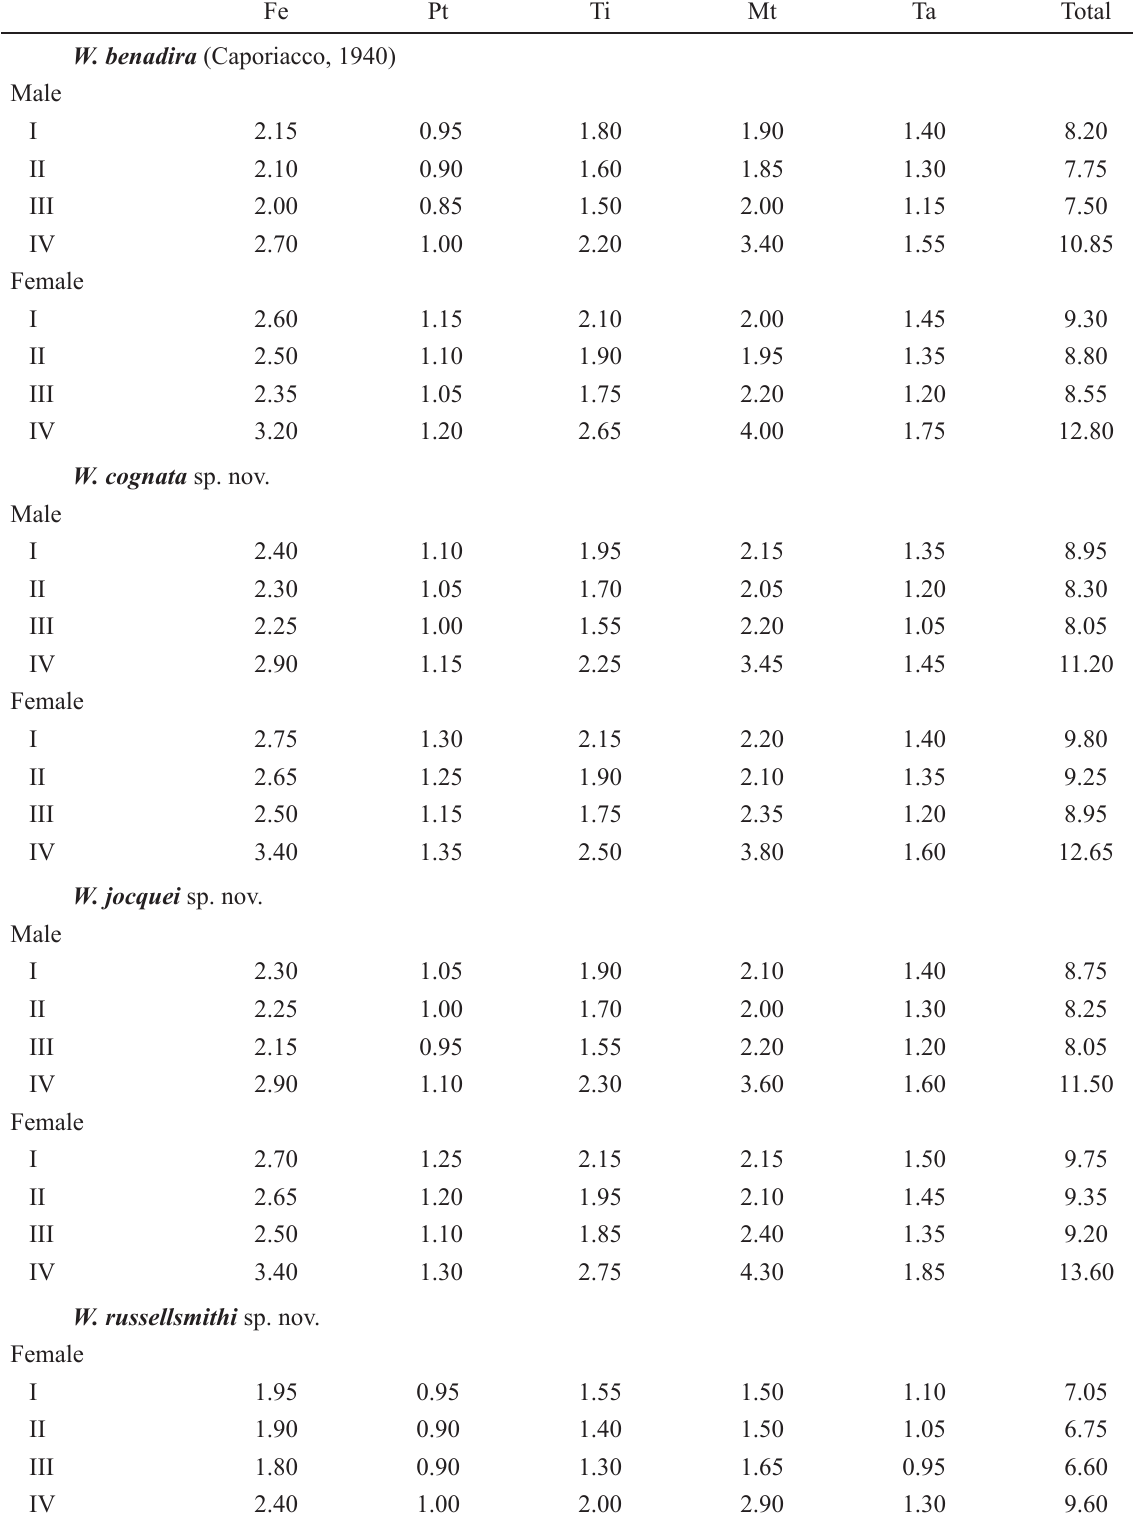
Table 1. Leg (I–IV) measurements (mm) in Wadicosa benadira (Caporiacco), W. cognata sp.